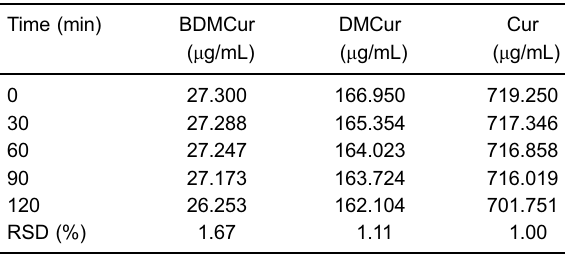
Table 6. Results of the absorption test of the intestinal wall by bisdemethoxycurcumin (BDMCur), demethoxycurcumin (DMCur) and curcumin (Cur).